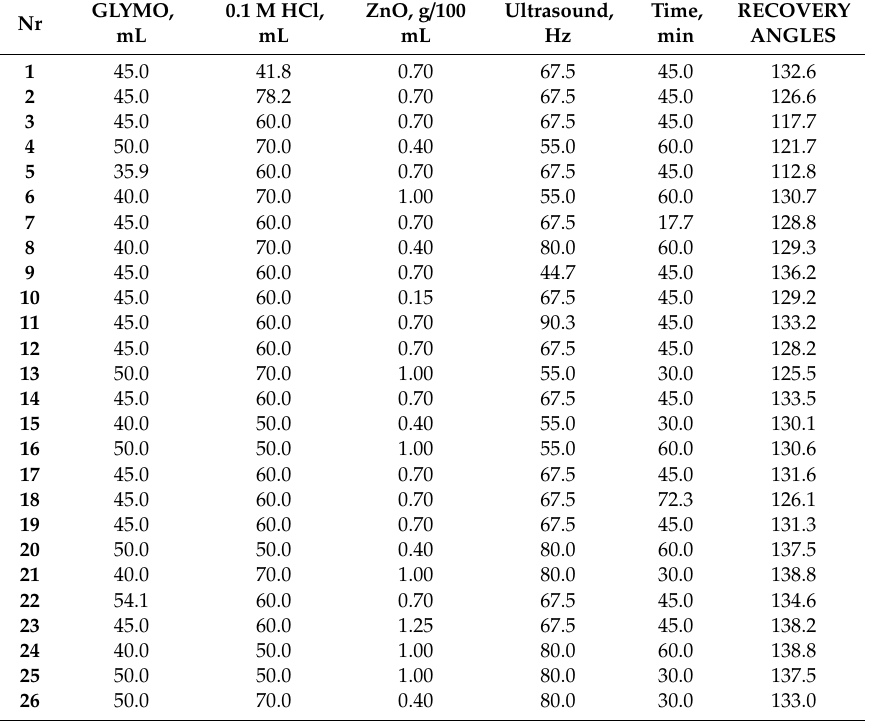
Table 1. Investigated parameters used during optimization of dip-coating process by Design of Experiment statistical methodology and calculated recovery